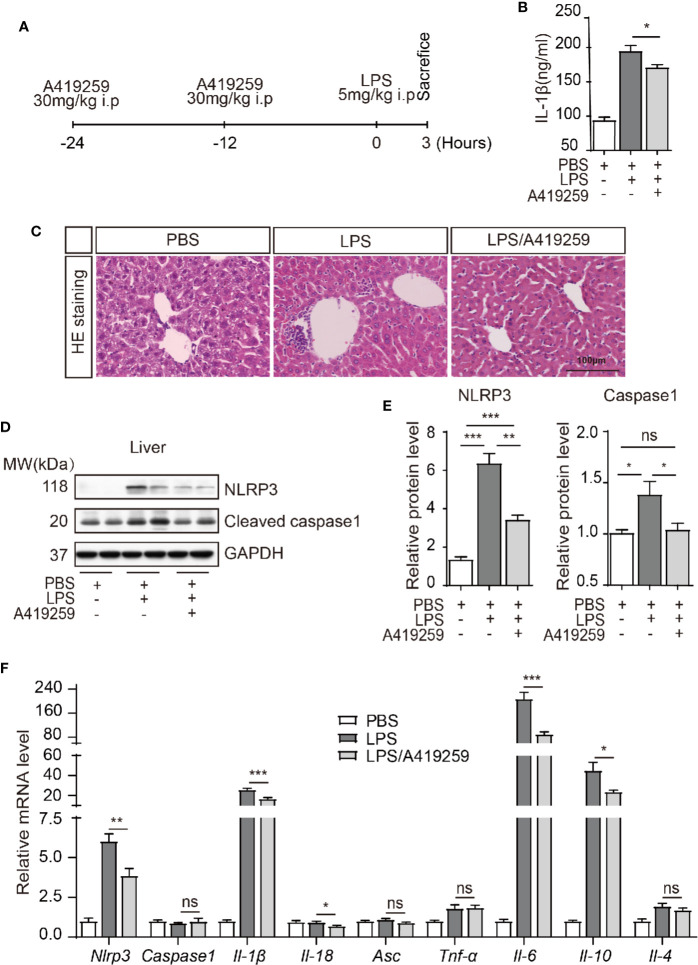
The HCK inhibitor A419259 attenuated LPS-induced inflammatory response in vivo.
(A) Schematic graph illustrating the experimental timelines. (B) ELISA of the serum cleaved IL-1β (P17) from mice intraperitoneally injected with LPS (5 mg/kg of body weight) with or without A419259 (30 mg/kg of body weight) (n = 7 for each group). (C) Representative images of liver H&E staining (three mice, nine slices each group). (D) Immunoblotting analysis of cleaved caspase 1 (P20), NLRP3, or GAPDH in the livers of mice intraperitoneally injected with LPS with or without A419259 (n = 7 for each group). (E) Analysis of the changes in NLRP3 or cleaved caspase 1 (P20) protein level. (F) qRT-PCR analysis of nlrp3, Caspase1, Il-1β, Il-18, Asc, Tnf-α, Il-6, Il-10, and Il-4 in the livers of mice intraperitoneally injected with LPS with or without A419259 (n = 7 for each group). Data show means ± SEM, *P < 0.05, **P < 0.01, ***P < 0.001. ns, P > 0.05, Student’s t-test.